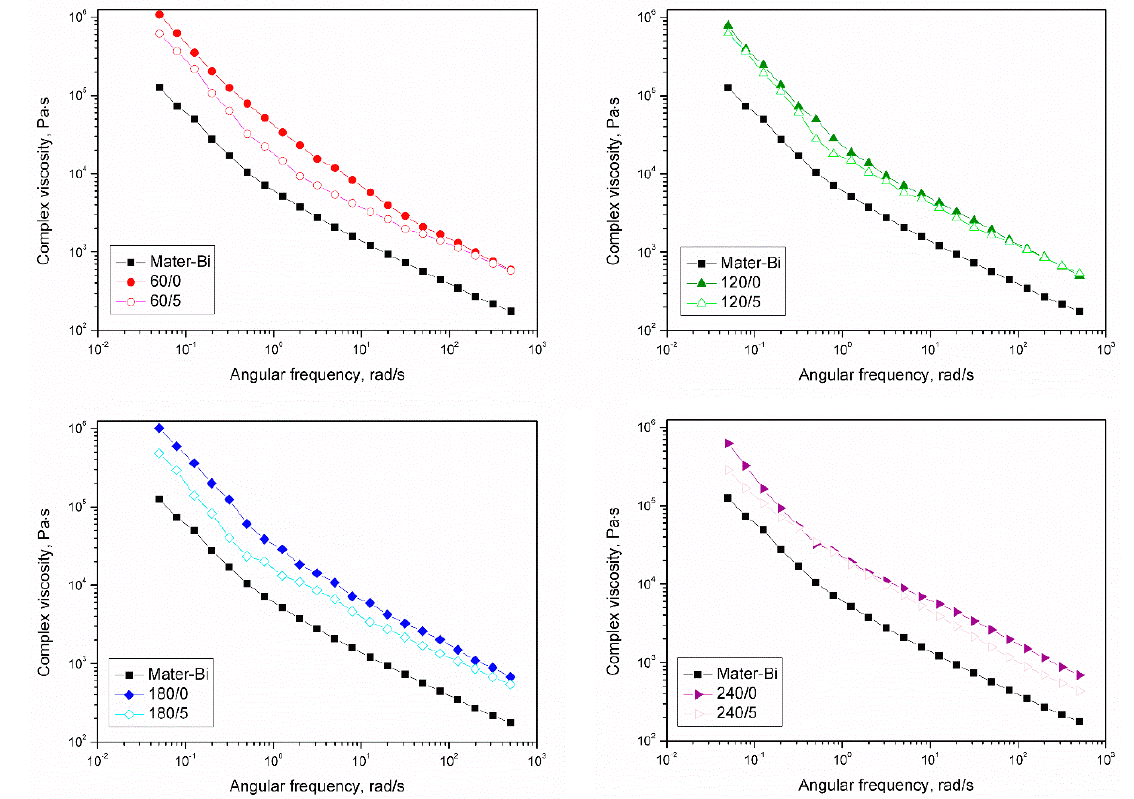
Figure 7. Complex viscosity curves of pure Mater-Bi and Mater-Bi composites filled with BSG subjected to various thermomechanical and chemical treatments.